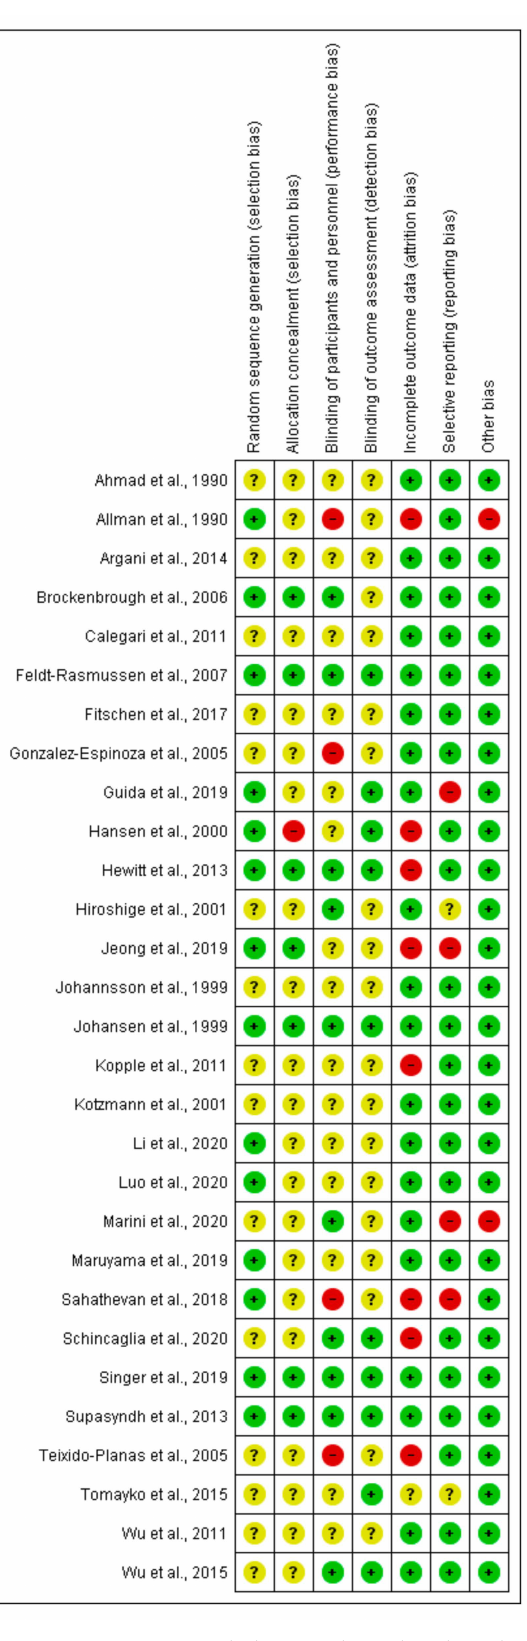
Figure A2. Nutrition and pharmacological trials in the dialysis population